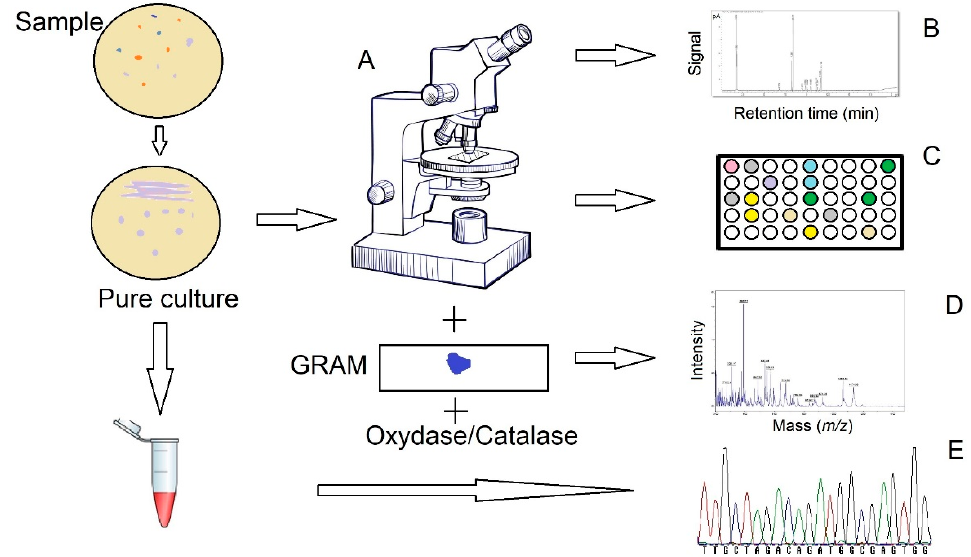
Figure 2. Schema of the analytical techniques used for the characterization of the bioaerosol culturable fraction ( A —Morphological characterization by microscopy, gram staining, oxidase, and catalase tests; B —FAME-GC; C —Microscan ® and Biolog ® ; D —Vitek ® -MS; E —Sequencing of bacterial 16S rRNA (Sanger)).